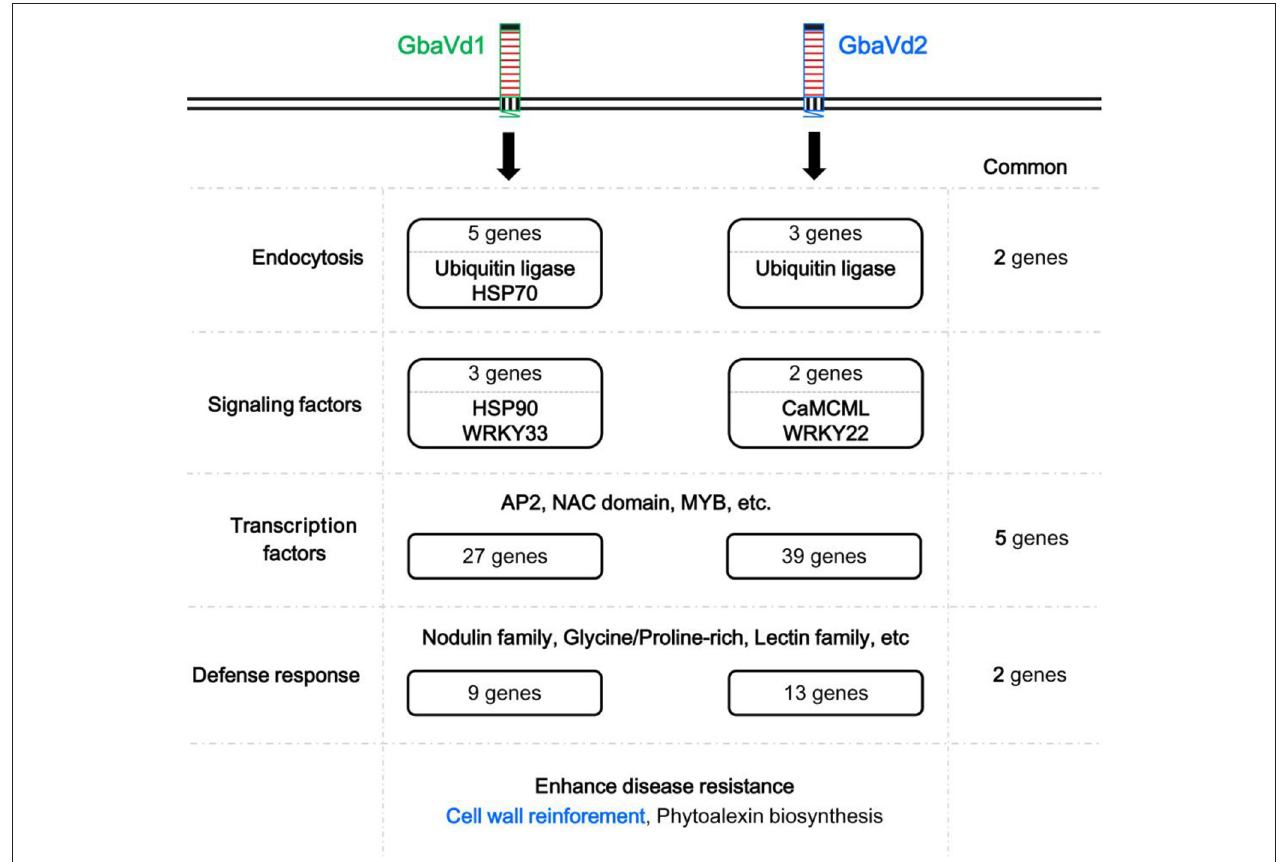
FIGURE 8 | Schematic overview of Verticillium wilt resistance mediated by GbaVd1 and GbaVd2